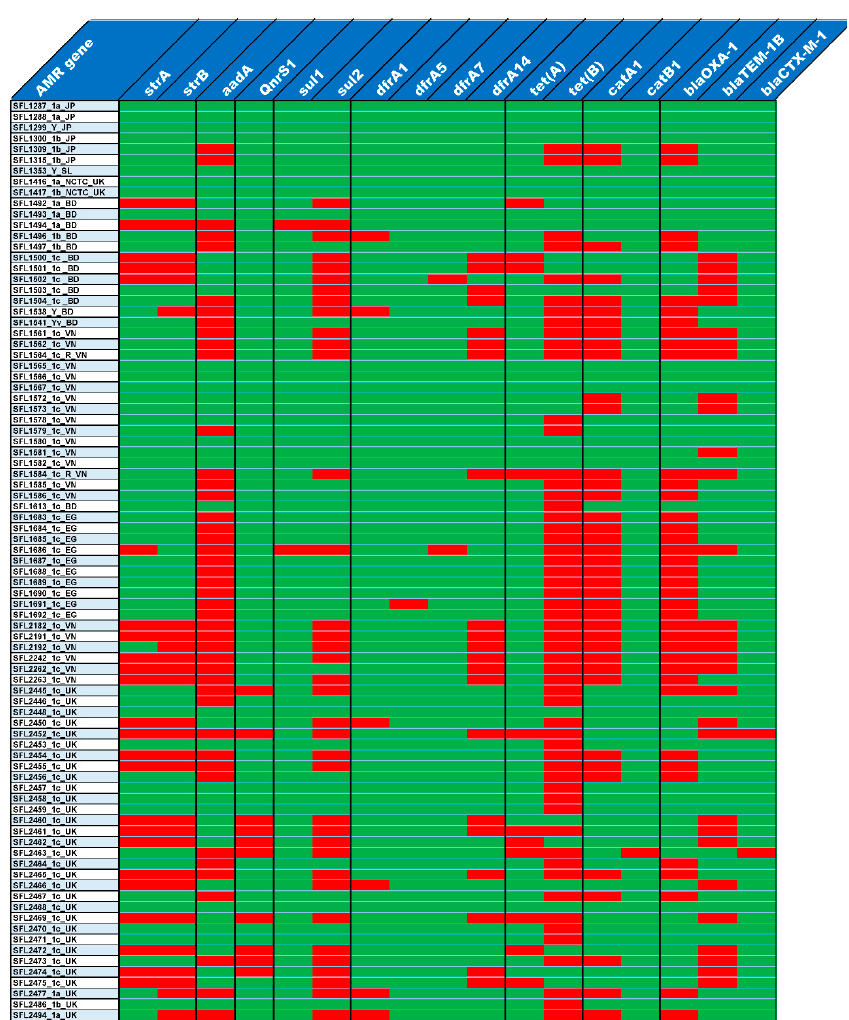
Figure 5. Antibiotic resistance gene profiles. The top row shows the list of antibiotic resistance genes and the left column shows the list of strains. The presence and absence of antibiotic resistance genes in each of the strains is shown in red and green colors,